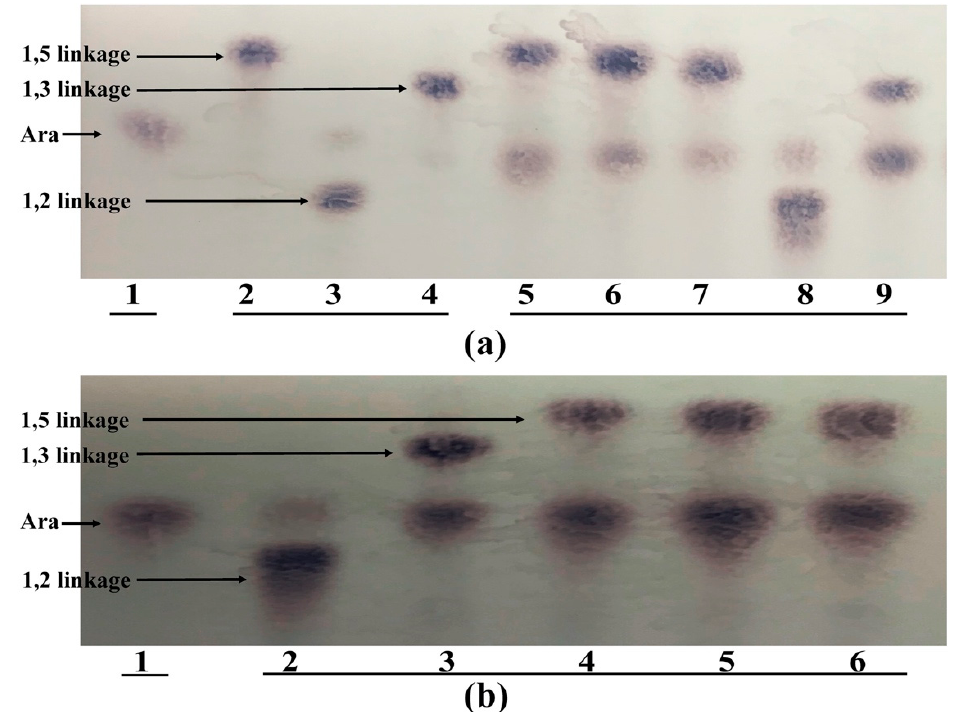
Figure 3. TLC analysis of the degradation products from cell wall-associated arabinosidase extracts from B. longum subsp. longum NCC 2705 ( a ) and Bac. caccae ATCC 43185 ( b ). For ( a ), lane 1: arabinose standard; lane 2: α -1,5-arabinobiose, 3: A2XX, 4: A3X, substrate control without crude enzymes; lane 5, 6, 7, 8, 9, crude cell wall-associated enzyme incubated with α -1,5 arabinobiose, α -1,5-arabinotriose, α -1,5-arabinotetraose, A2XX and A3X, respectively. For ( b ): lane 1, arabinose standard; lane 2, 3, 4, 5, 6, crude cell wall-associated enzyme incubated with A2XX, A3X, α -1,5-arabinobiose, α -1,5-arabinotriose and α -1,5-arabinotetraose.